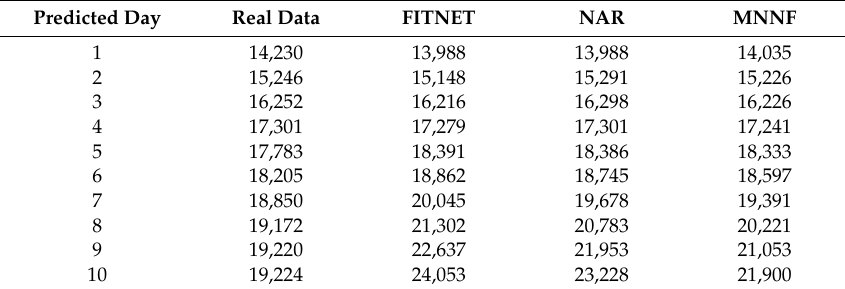
Table 1. Comparison of predicted values for confirmed cases of Covid-19.